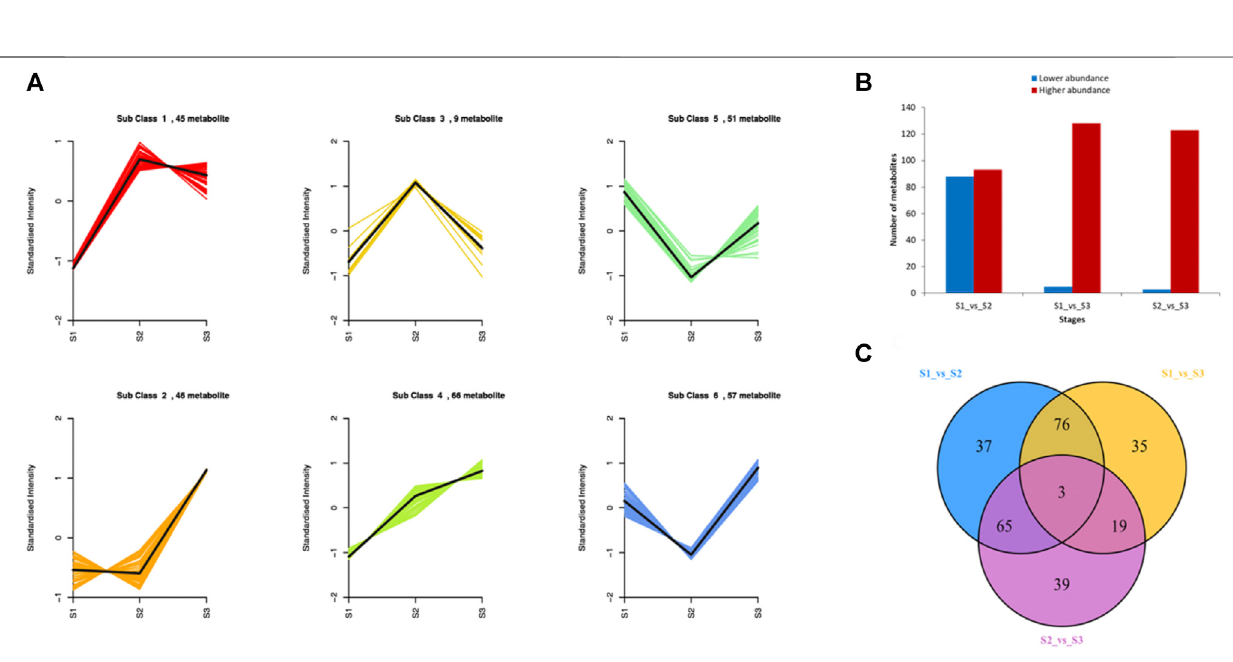
Frontiers in Genetics |